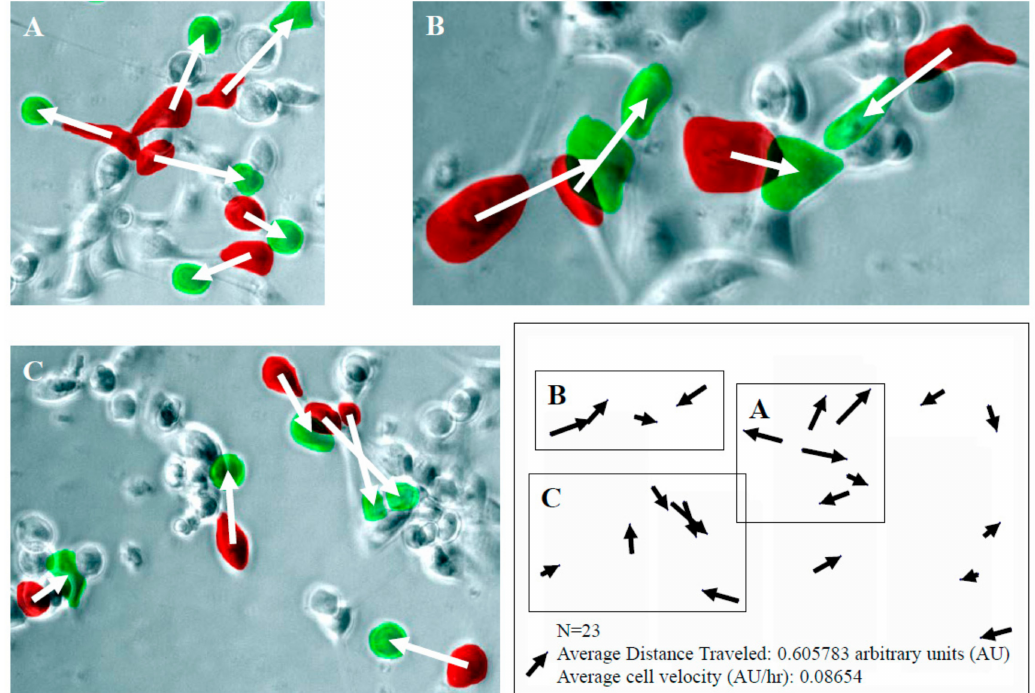
Figure 4. Detailed analysis of the rate of migration (in arbitrary units) of DU145 cells, in response to CM from PrSC. Two images, one taken at t = 0 h and a second one taken at t = 7 h were overlaid using Adobe Photoshop. Cells at t = 0 were labeled red, and cells at t = 7 were labeled green. 23 individual CM-treated DU145 cells located in three di ff erent microscopic fields, labeled as ( A ), ( B ), or ( C ) were used to calculate the average distance and rate of migration. The coordinates for each cell were obtained for each of the two time points and schematically shown in the lower right corner of Figure 4. The change in the distance migrated for each cell ( n = 23) was calculated using the coordinates. The rate of cell migration was determined by the distance traveled as a function of